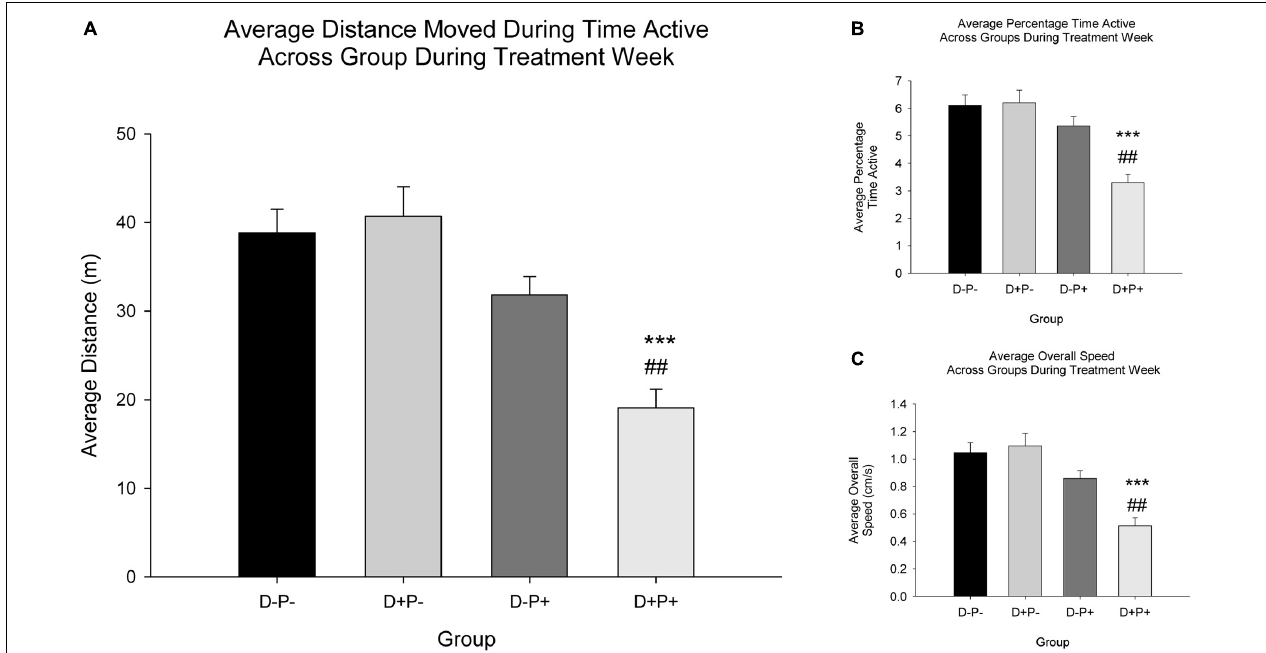
FIGURE 8 | Locomotor parameters across groups during treatment week. (A) Average distance moved during time active (m); (B) Average percentage time active; (C) Average overall speed (cm/s). A significant decrease in all three parameters (A–C) was observed in the D+P+ group relative to all other groups (D − P − , D+P − ,